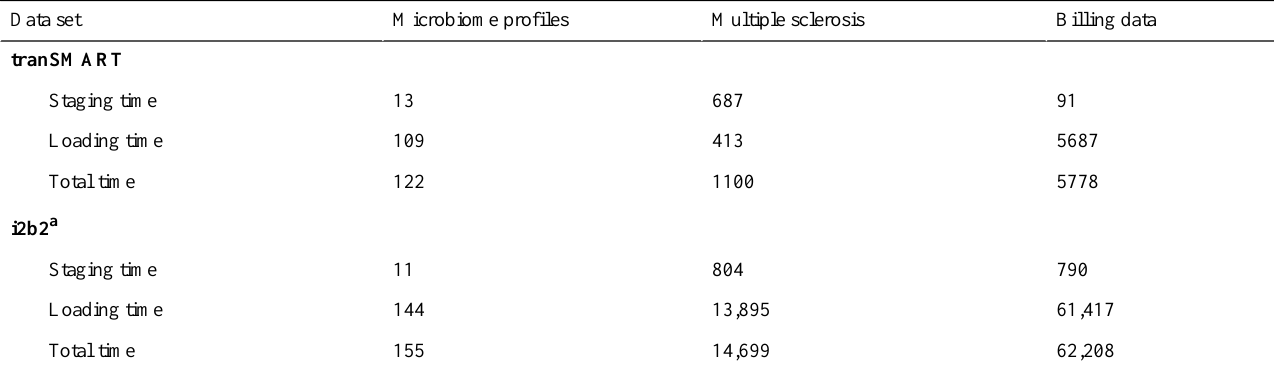
Table 3. Execution times of data-loading processes in